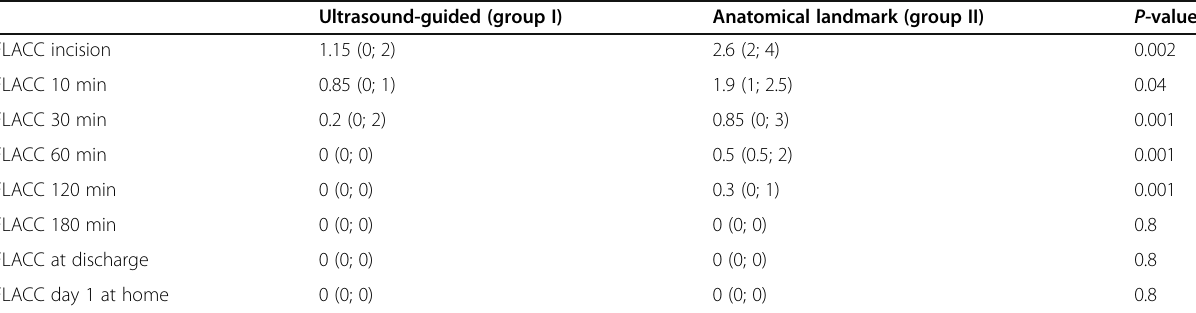
Table 3 FLACC score versus time Ultrasound-guided (group I) Anatomical landmark (group